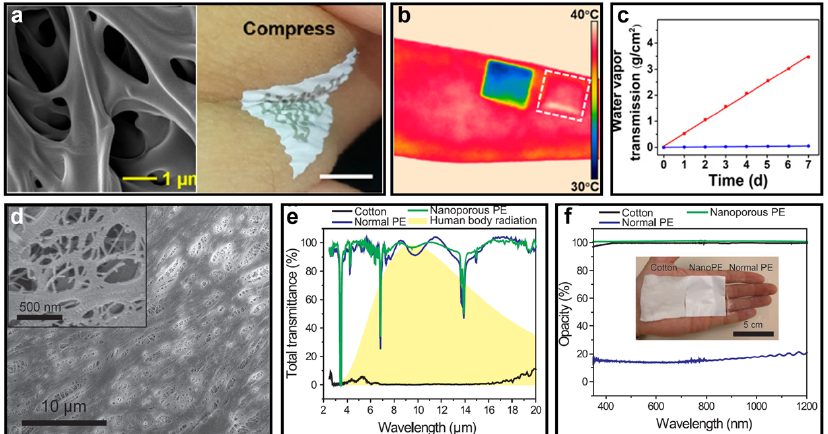
Figure 1. ( a ) Microscopic and macroscopic images of a nanoporous SEBS structure as a substrate attached to human epidermis. ( b ) Comparison of the passive cooling function of nanoporous and nonporous SEBS substrates. ( c ) The water vapor transmission of nanoporous SEBS (red) and nonporous SEBS (blue). (( a – c ) Reprinted with permission from Ref. [47], Copyright 2019 National Academy of Sciences.) ( d ) Picture of nanoPE obtained from SEM. ( e ) Transmissions of body radiation of different material-based substrates. ( f ) Opacity under visible light of different material-based substrates. (( d – f ) Reprinted with permission from Ref. [48], Copyright 2016 The American Association for the Advancement of Science.).